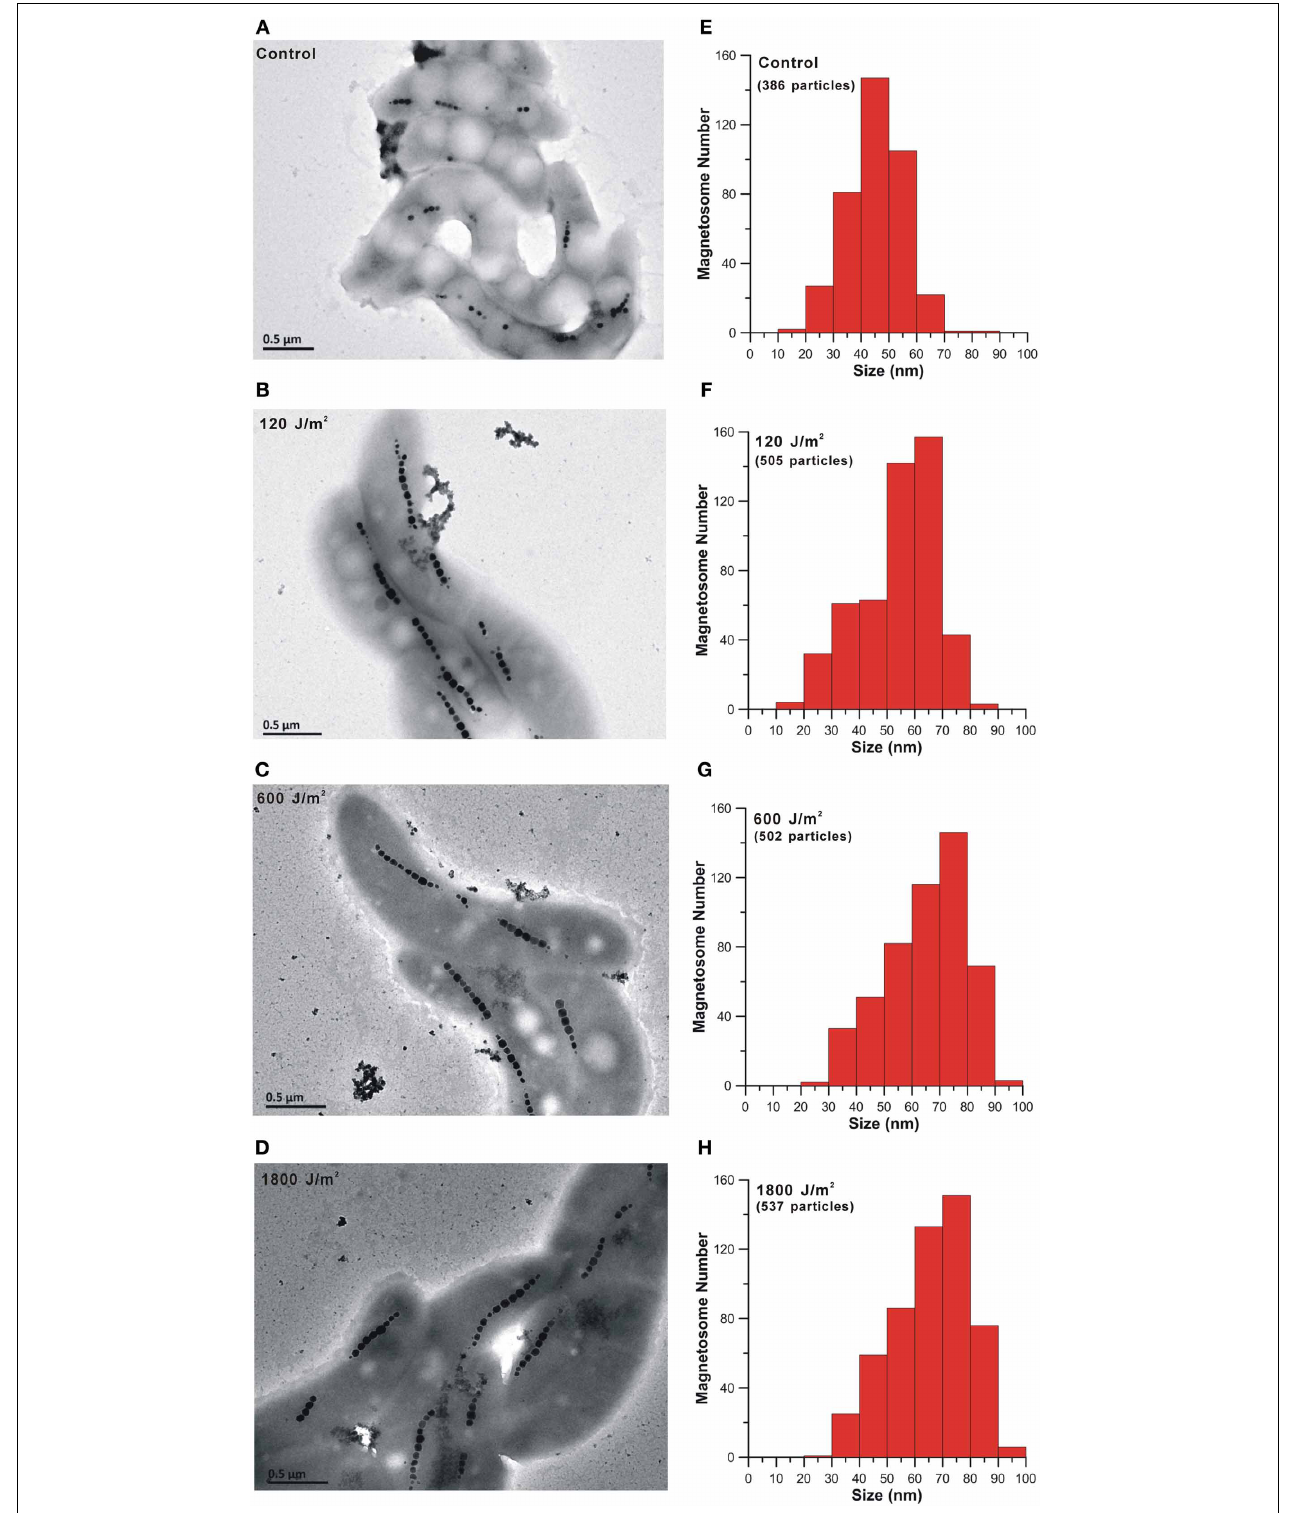
FIGURE 4 | TEM micrographs of cell morphology and magnetosome chains and histograms of magnetosome grain sizes of the control (A and E) and the irradiated AMB-1 cells (B–D and F–H).